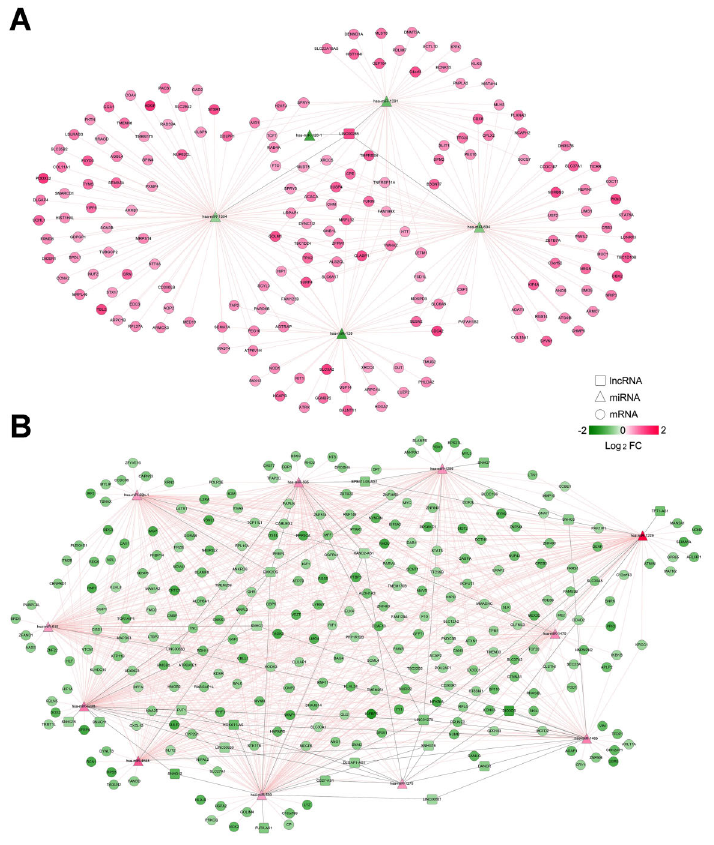
Figure 2. Construction of a competing endogenous RNA network among differentially expressed lncRNAs, miRNAs, and genes. A , Relationship pairs among upregulated lncRNA, downregulated miRNAs, and upregulated mRNAs; B , Relationship pairs among downregulated lncRNAs, upregulated miRNAs, and downregulated mRNAs. Red: upregulated; green: downregulated.